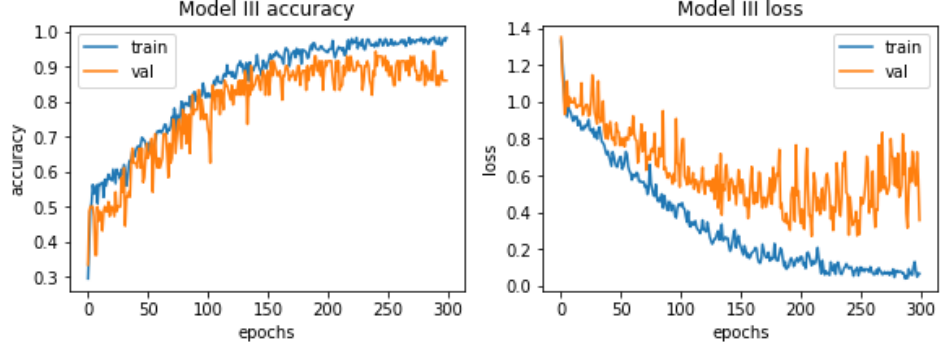
Figure 15. Accuracy and losses when teaching the third model.